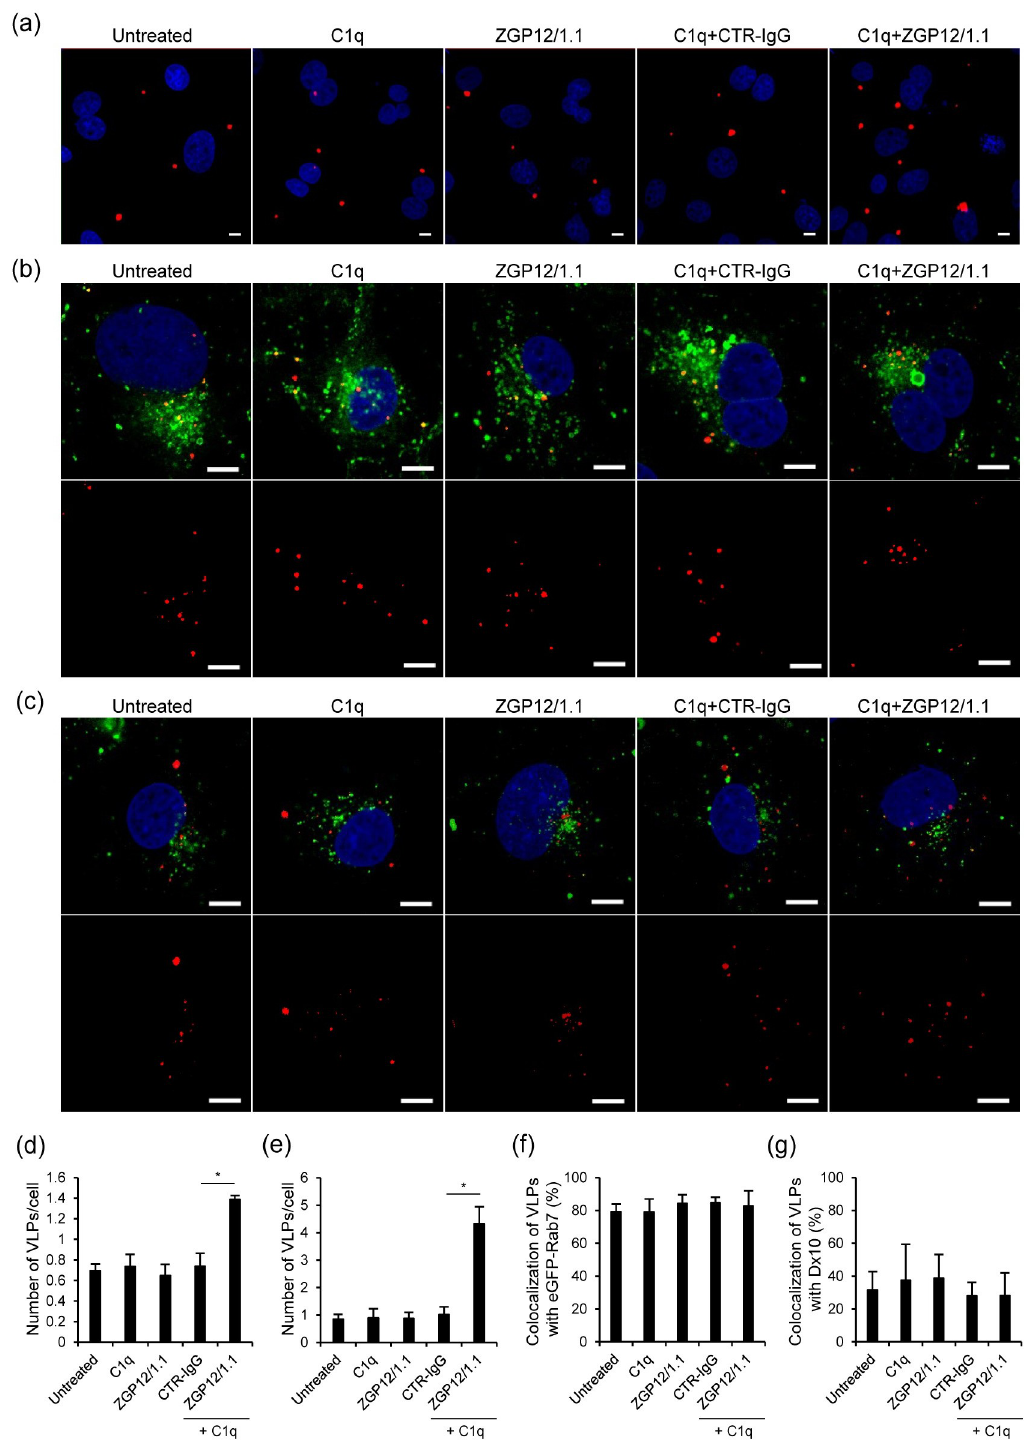
Fig 5. Enhanced VLP attachment to the cell surface in the presence of ZGP12/1.1 and C1q. (a, b, c) Fluorescent images of attachment and trafficking to late endosomes of VLPs. (d, e, f, g) Quantified fluorescent signals of VLPs, Rab7, and Dx10. HEK293 cells expressing eGFP-Rab7 (a, b) or HEK293 cells (c) were inoculated DiI-labeled VLPs mixed with PBS (Untreated), or treated with C1q (20 μ g/ml) alone, ZGP12/1.1 (10 μ g/ml) alone, CTR-IgG (10 μ g/ml) and C1q, or ZGP12/1.1 and C1q. After adsorption, cells were incubated with Alexa647-labeled Dx10 (0.5 mg/ml) for 2 h at 37˚C (c). VLPs (red) on the cell surface at 0 h (a, d), VLPs (red) and eGFP-Rab7 (green) in the cytoplasm at 2 h (b, e, f), and VLPs (red) and Alexa647-labeled Dx10 (green)